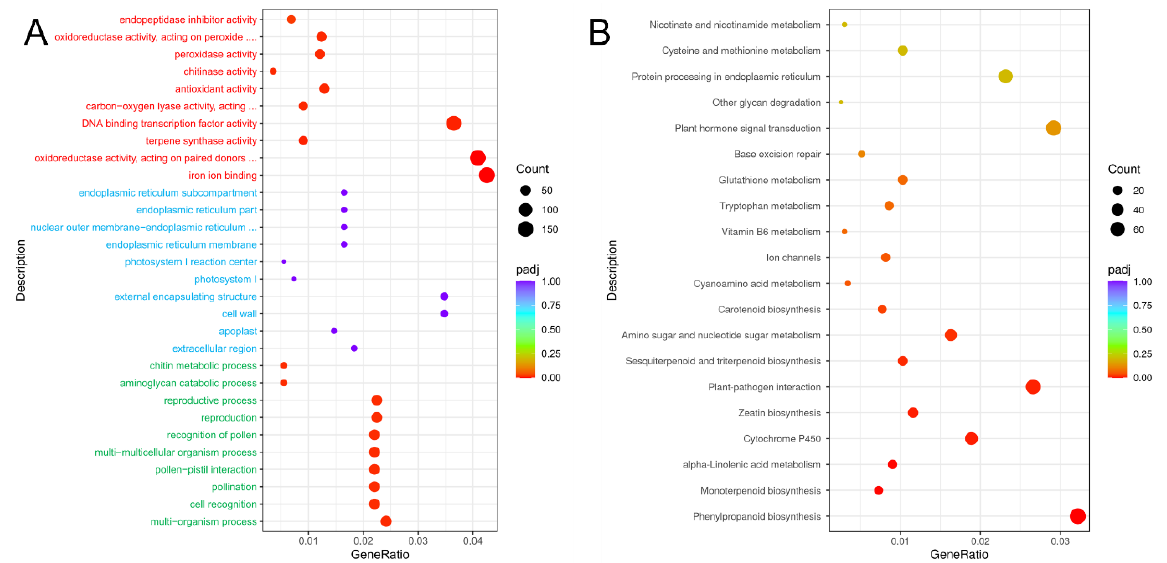
Figure 6. GO enrichment analysis and KEGG metabolic pathway analysis of DEGs. ( A ) GO enrich- ment analysis scatter plot. ( B ) KEGG metabolic pathway analysis scatter diagram. Note: green font indicates ‘ b iological process’ ; b lue font indicates ‘ c ellular component’ ; r ed font indicates ‘ molecular function’.